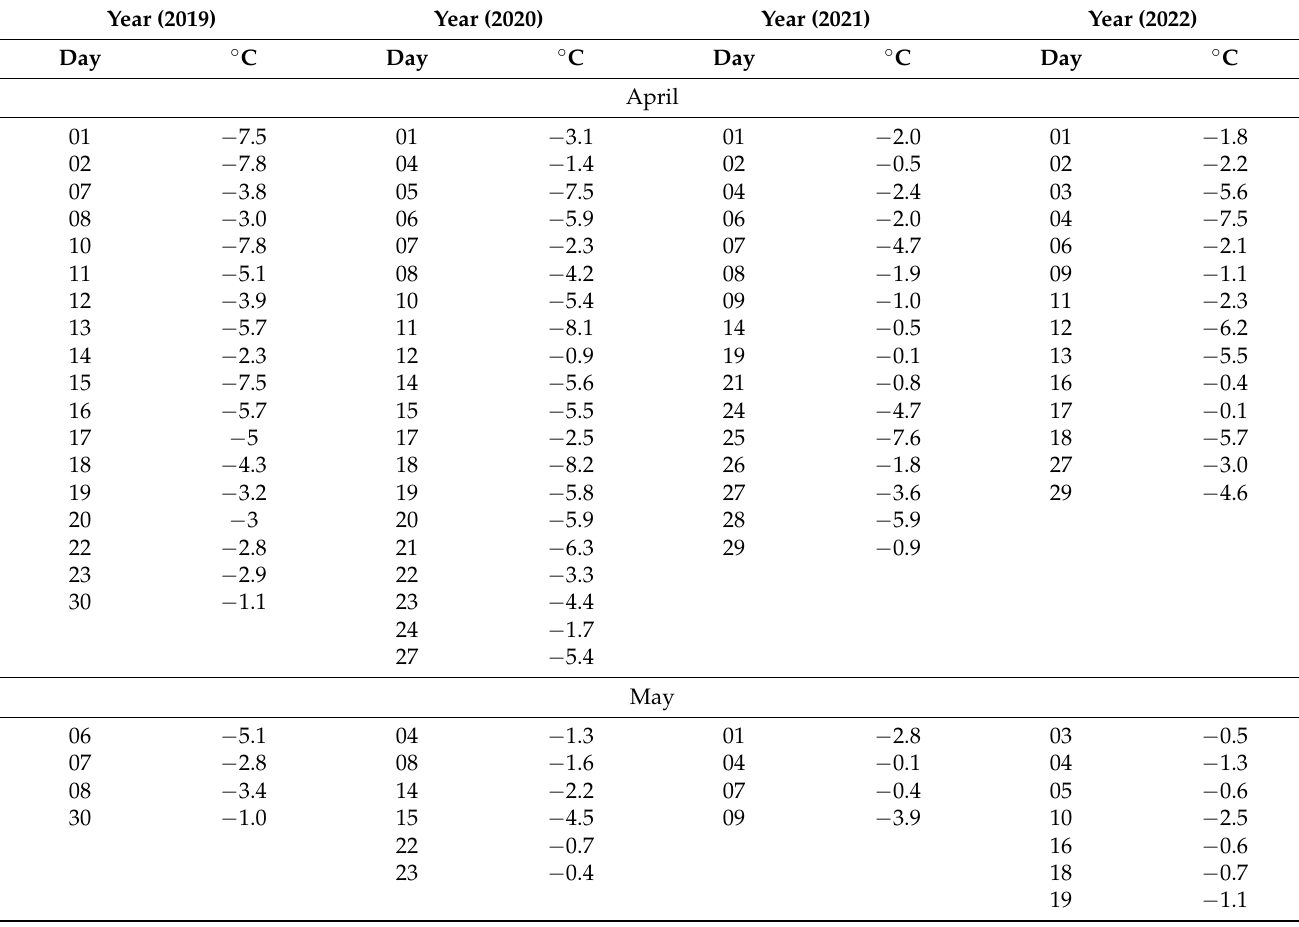
Explanations: Green color indicates the growing season. Table 2. Spring ground frosts in Olsztyn (north-eastern Poland) in 2019–2022 (data obtained and processed from the station of the Institute of Meteorology and Water Management